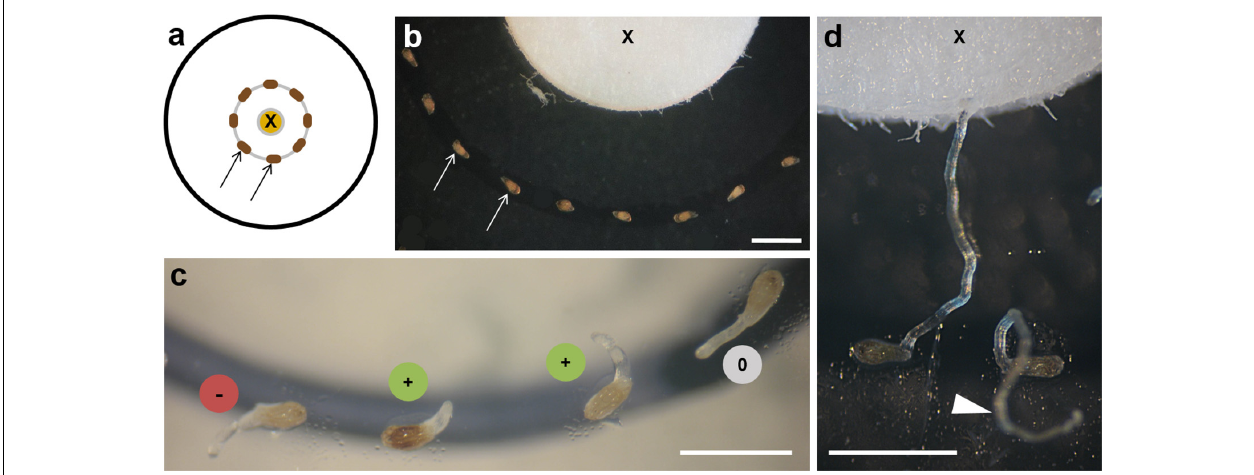
FIGURE 2 | Chemotropism bioassay. (a) Diagram of bioassay showing the source of the test substance on the filter disc ( X ) and seeds ( arrows ) placed at a 2-mm distance. (b) Seeds of O. cumana ( arrows ) around the filter ( X ) with their micropyle facing alternately left and right. (c) Early stages of germ tube development: (+) bending toward the substance source; (–) away from it; (0) behaving indifferently. (d) Two examples of late stages of germ tube development: one touching the filter with the tested substance ( X ), the other growing without orientation above the substrate ( arrowhead ). Scale bars = 1 mm.